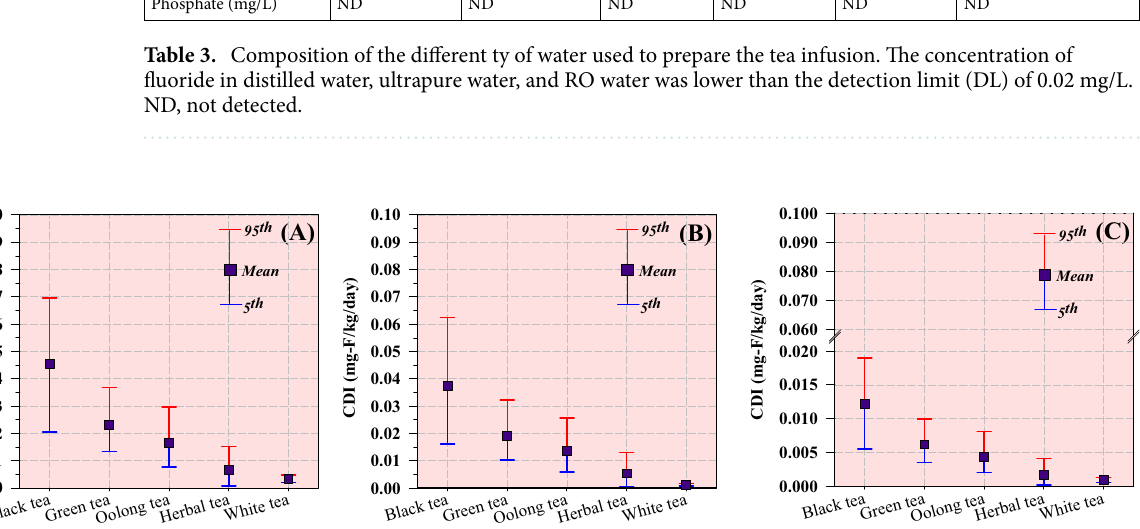
Figure 4. CDI in the ( A ) children, ( B ) teenagers, and ( C ) adults for the consumption of uncrushed tea and herbal